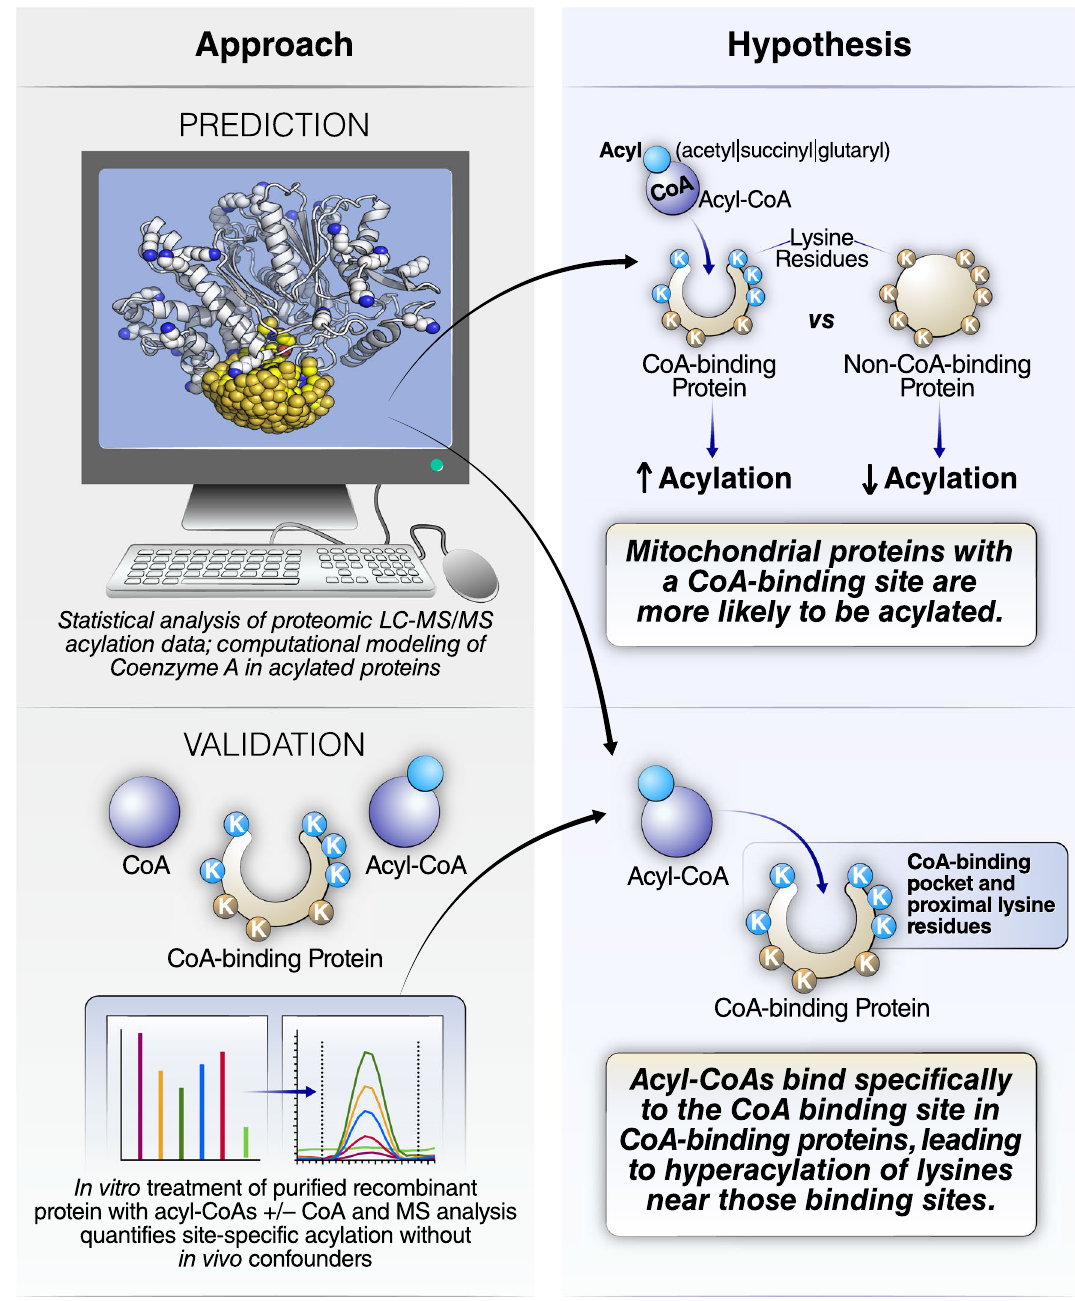
Figure 1. Computational modeling and mass spectrometry analysis revealed the mechanism of lysine acylation on CoA-binding protein within the mitochondria. ( a ) Schematic diagram of the experimental approaches in this study and the hypotheses tested. Statistical analyses of proteome-wide MS acylation datasets using database annotation data, and subsequent structural modeling of acylated proteins, generated a proposed mechanism for CoA-binding-protein hyperacylation. This mechanism was validated by in-vitro MS analysis of a reported acylated